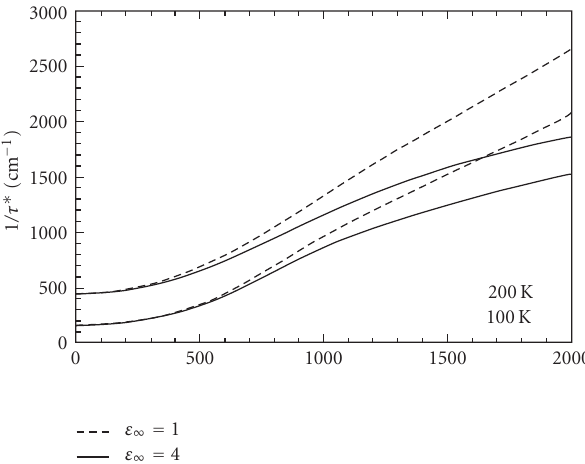
Figure 6: Dependence of γ ∗ ( ω , T ) on ε ∞ in Bi 2 Sr 2 CaCu 2 O 8 for tr di ff erent temperatures: ε ∞ = 4 (solid lines) and ε ∞ = 1 (dashed lines). On the horizontal axis is ω in units cm − 1 . From